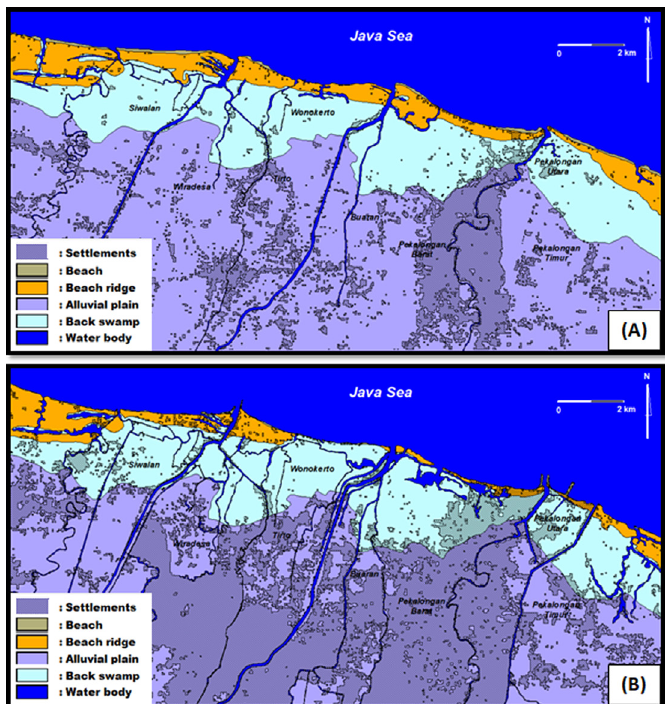
Fig. 13. Comparison of settlement distribution located on coastal landform between 1978 and 2017 in the study area. (A) Settlement on coastal landforms in 1978; (B) Settlement on coastal landforms in 2017.